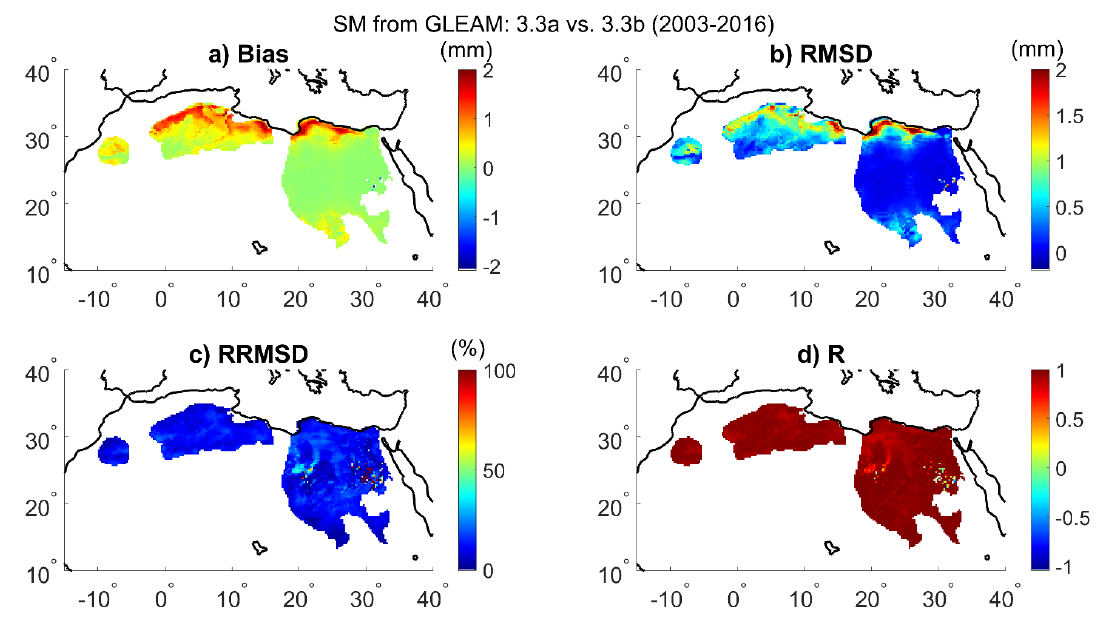
Figure 4. Maps of bias ( a ); RMSD ( b ); RRMSD ( c ); R ( d ) between SM from GLEAM v3.3a and v3.3b over 2003–2016.